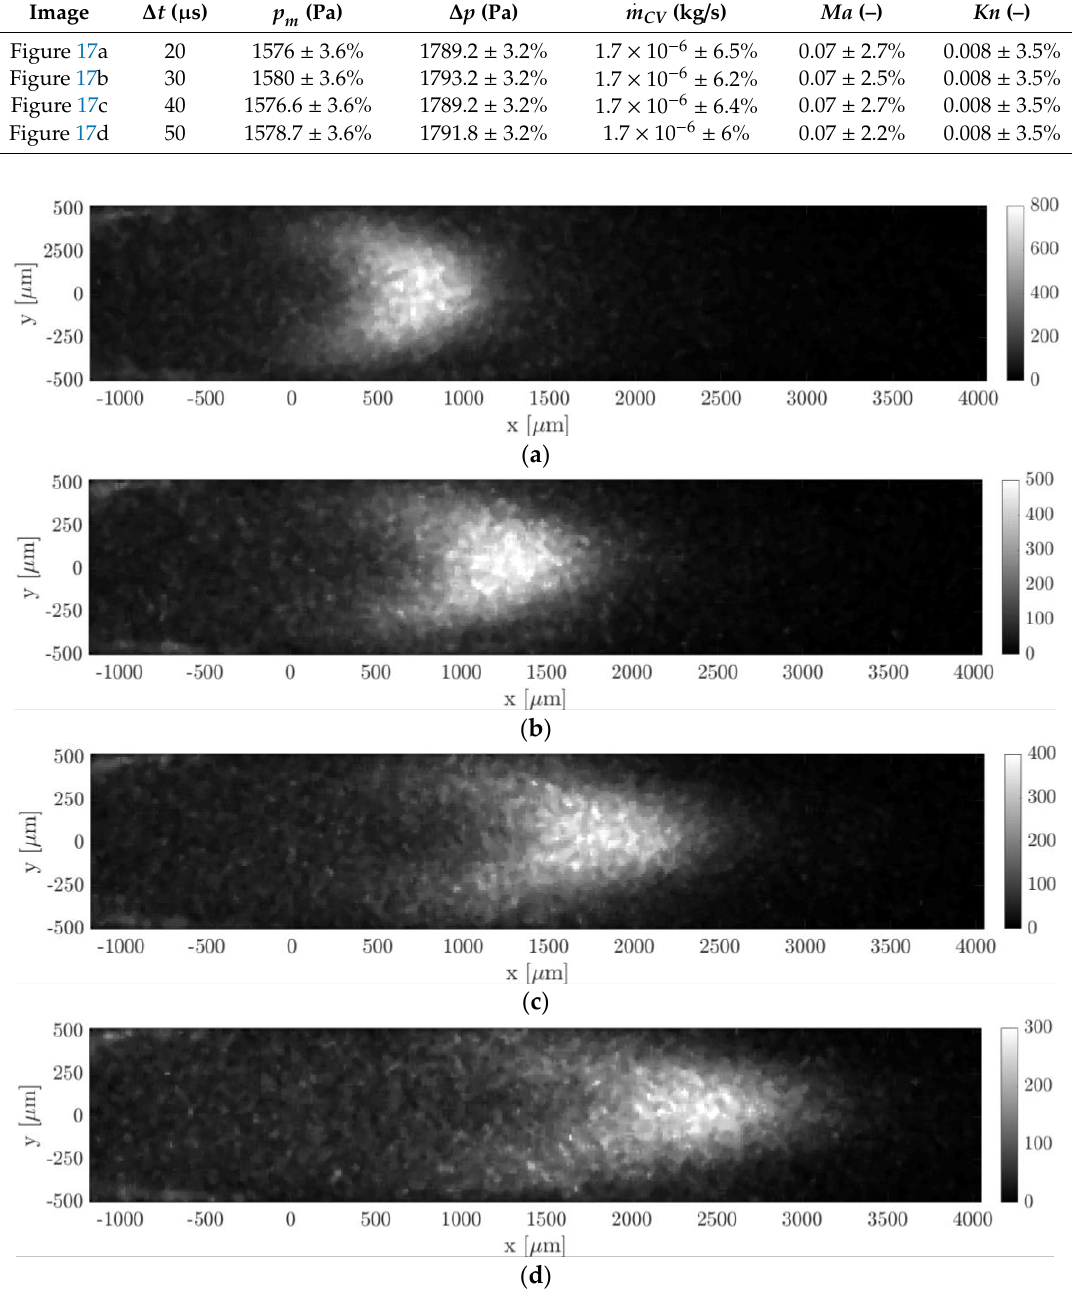
Figure 17. MTV acquisitions of helium–acetone flow with 𝜒 = 20%: ( a ) Δ𝑡 = 20 µs, 𝑝 𝑚 = 1576 Pa, and Δ𝑝 = 1789.2 Pa; ( b ) Δ𝑡 = 30 µs, 𝑝 𝑚 = 1580 Pa, and Δ𝑝 = 1793.2 Pa; ( c ) Δ𝑡 = 40 µs, 𝑝 𝑚 = 1576.6 Pa, and Δ𝑝 = 1789.2 Pa; and ( d ) Δ𝑡 = 50 µs, 𝑝 𝑚 = 1578.7 Pa, and Δ𝑝 = 1791.8 Pa. The recording parameters used are: 𝑁 𝑙 = 100, 𝑁 𝑖 = 20, 𝐺 = 100%, and Δ𝑡 𝑔𝑎𝑡𝑒 = 500 ns. The acquisitions are made with a 4 × 4 binning. The laser pulse energy was varying between 80 and 120 µJ.